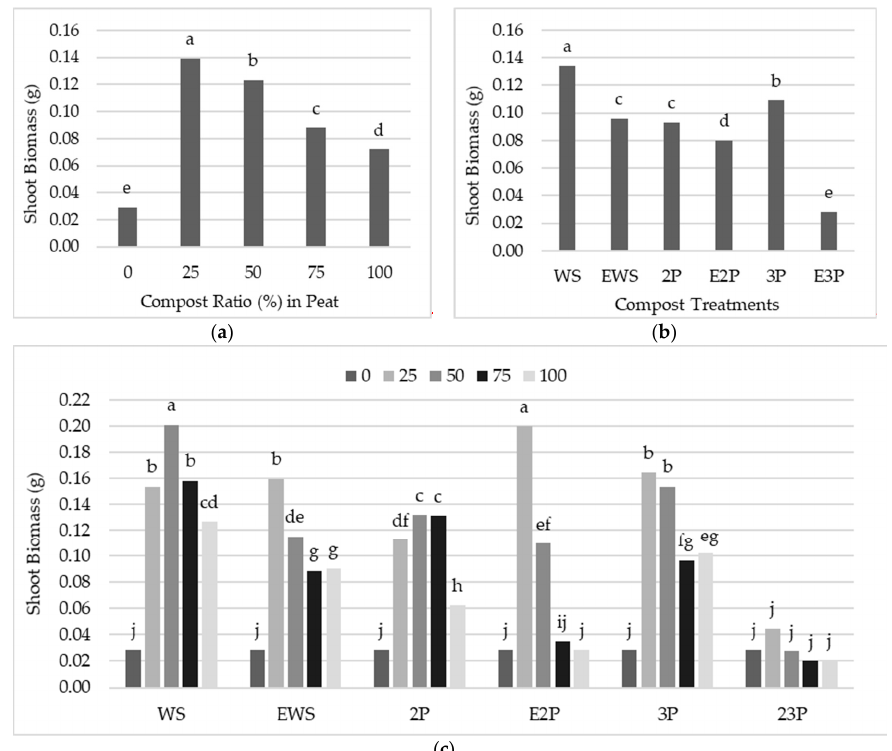
Figure 3. Main ( a , b ) and interaction ( c ) effects of the treatments on shoot dry weight. Means within each column followed by the same letters are not significantly different according to the Tukey test.